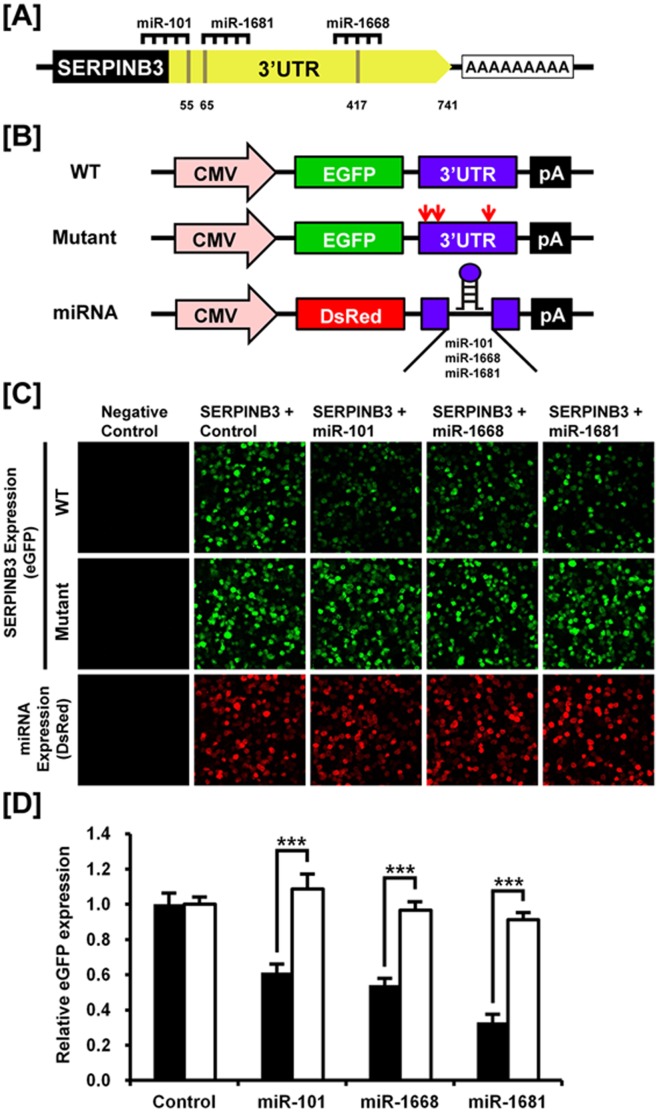
Immunohistochemistry was used to demonstrate expression of SERPINB3 protein in cancerous ovaries, but not in normal ovaries from women.(a and a′) Weak, (b and b′) moderate and (c and c′) strong expression of SERPINB3 protein was detected in women with epithelial ovarian cancer. There was either no expression of very weak expression of SERPINB3 in normal ovaries, whereas SERPINB3 protine was easily detectable in cancerous ovaries from women. The negative control used was mouse IgG instead of primary antibody. Scale bar represents 200 μm (the first horizontal panels and IgG) or 50 μm (the second horizontal panels).